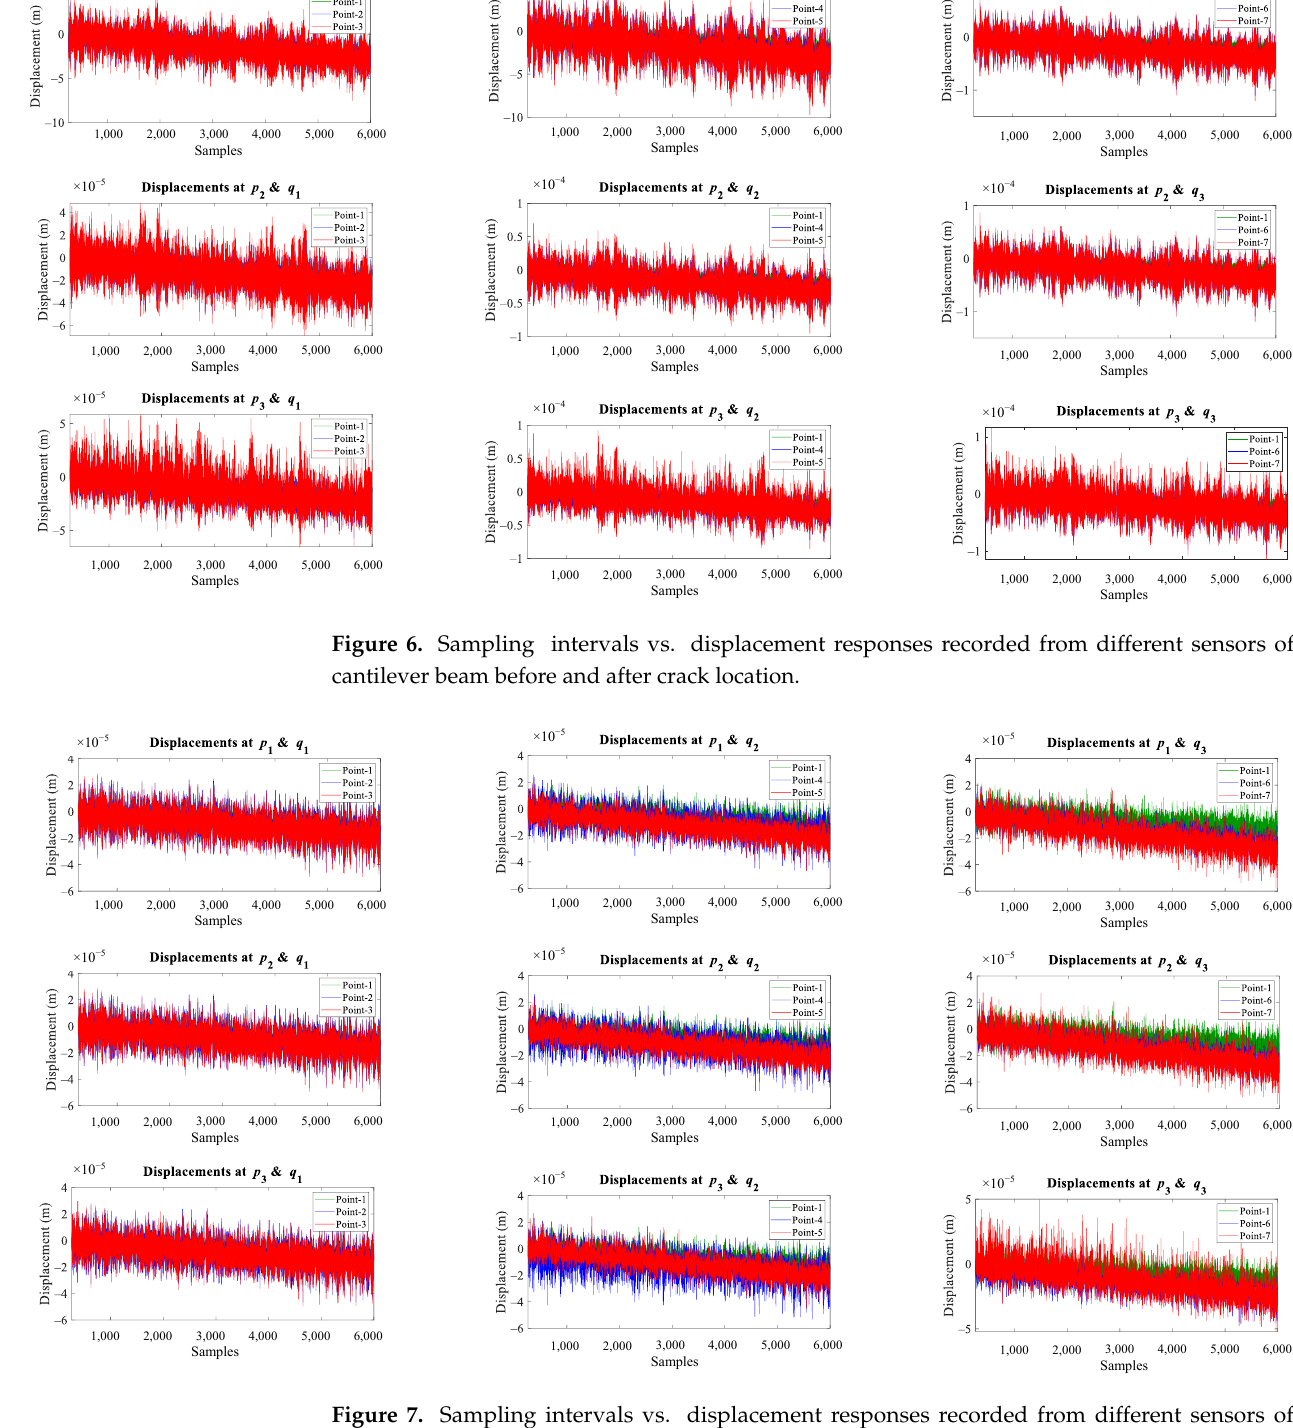
Figure 7. Sampling intervals vs. displacement responses recorded from different sensors of a cantilever, simply supported beam before and after crack